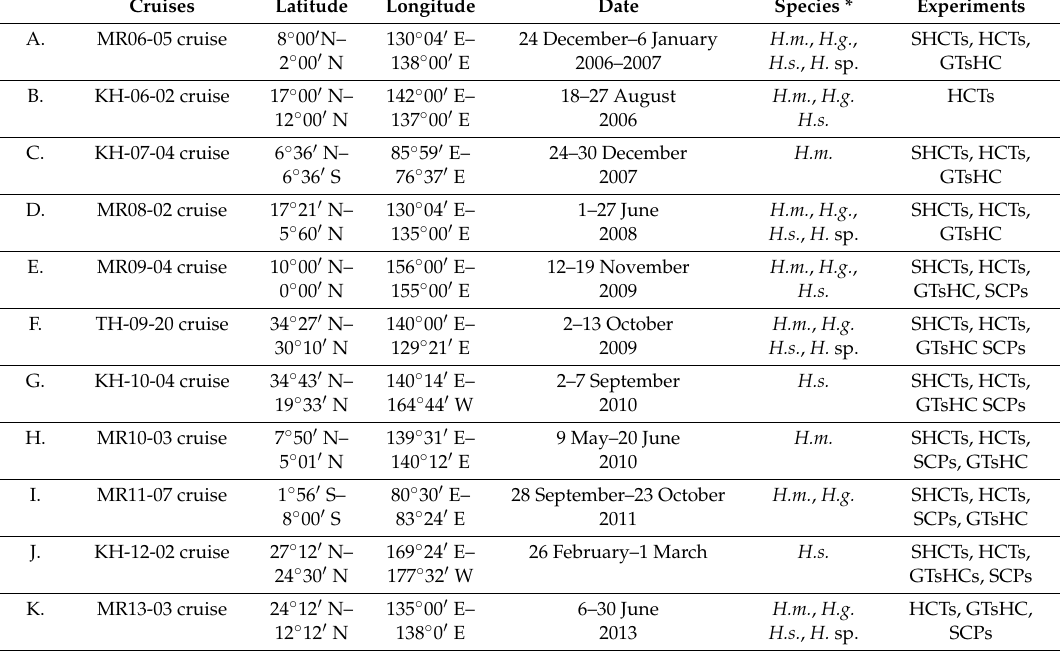
Table A1. The sea area, season, and year of specimens collected during the cruises to examine semi heat coma temperatures (SHCTs), heat coma temperatures (HCTs), gap temperatures for heat coma (GTsHC) and super cooling temperatures (SCPs) in the oceanic sea skaters, Halobates . Cruises